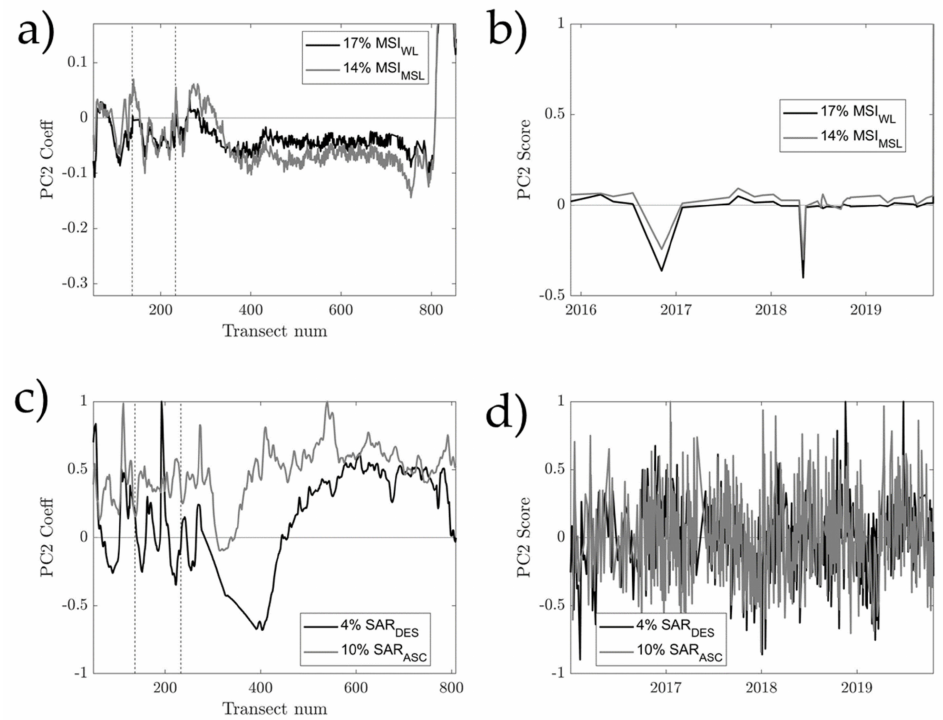
Figure 19. Second principal component (PC2) spatial and temporal results of the Start Bay area using MSI WL & MSL, and SAR DES & ASC. The percentage of total variability explained is indicated in each figure legend. The alongshore distribution of the PC2 coefficients ( a , c ) shows dominant patterns in shoreline change, and the time series of the PC2 scores ( b , d ) illustrates any temporal association of these key modes. The values shown for both coeff. and scores has been normalized by the maximum absolute value to represent results from different datasets in the same